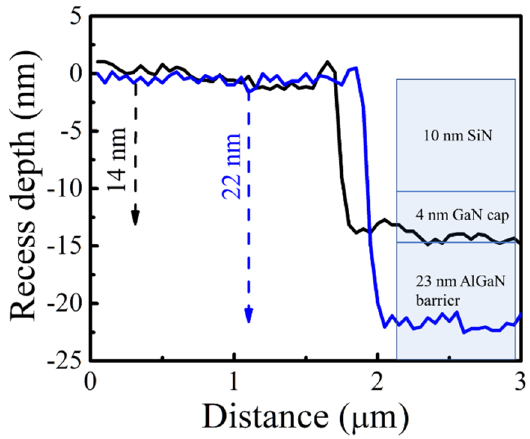
Figure 4. The etch depth of the gate region recess measure by AFM. The etch depth of 22 nm corre-